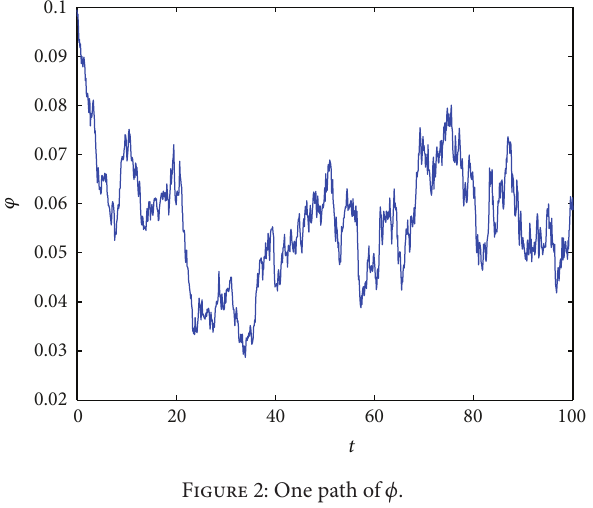
Figure 2: One path of 𝜙